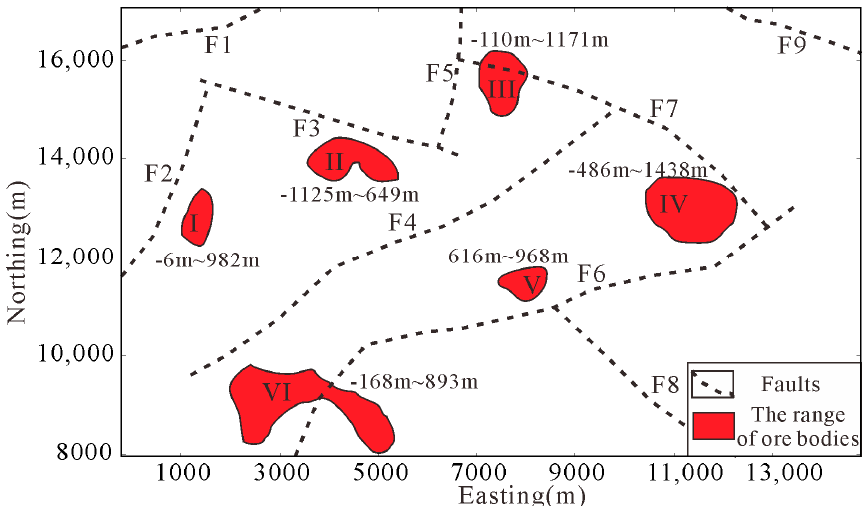
Figure 9. The range of ore bodies interpreted from 3D inversion results.